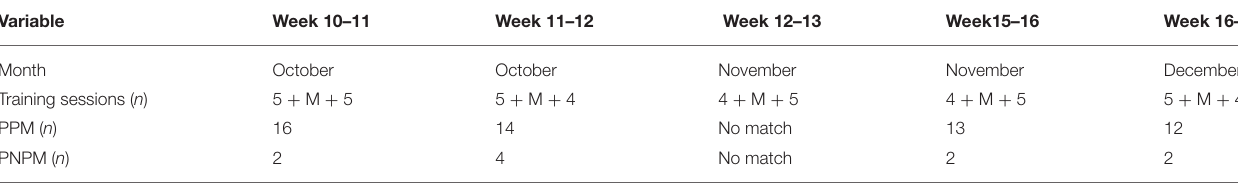
TABLE 1 | Characterization of the analyzed weeks in this study.